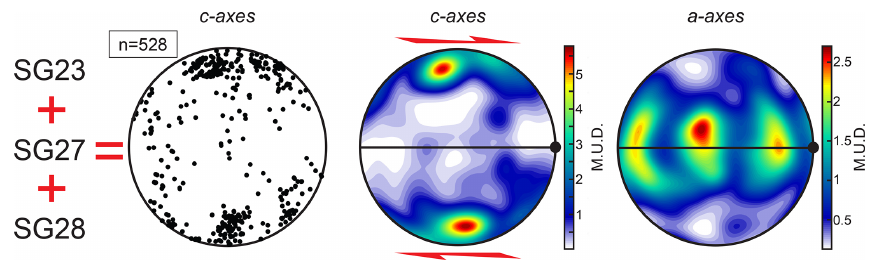
Figure 8. Combined data (one point per grain) from SG23, SG27 and SG28 in the same kinematic reference frame. Plots from left to right show c axes uncontoured, c axes contoured and a axes